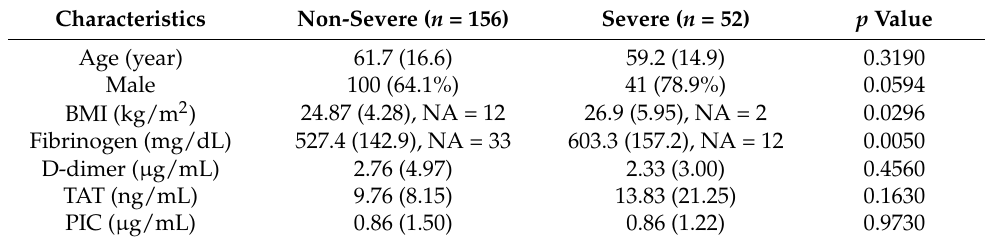
Table 5. Characteristics of patients with elevated